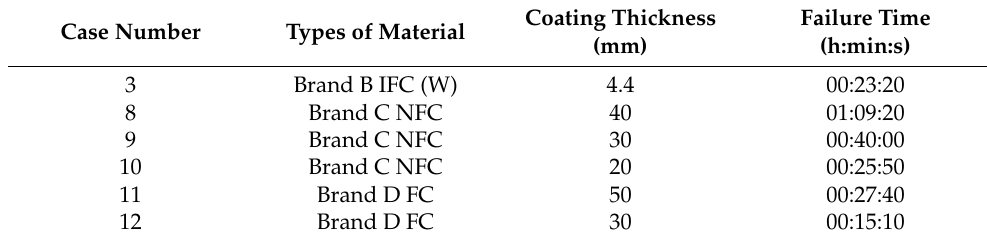
Table 9. Failure time data for some